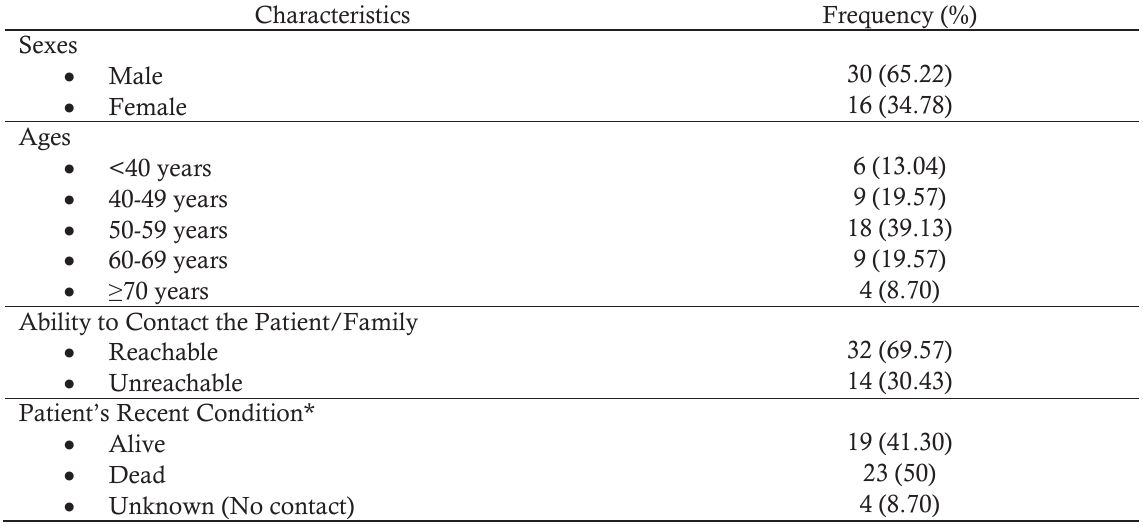
Table 1. Baseline data of Patients with family history, bloody stool, palpable mass, anemia, and abdominal MSCT